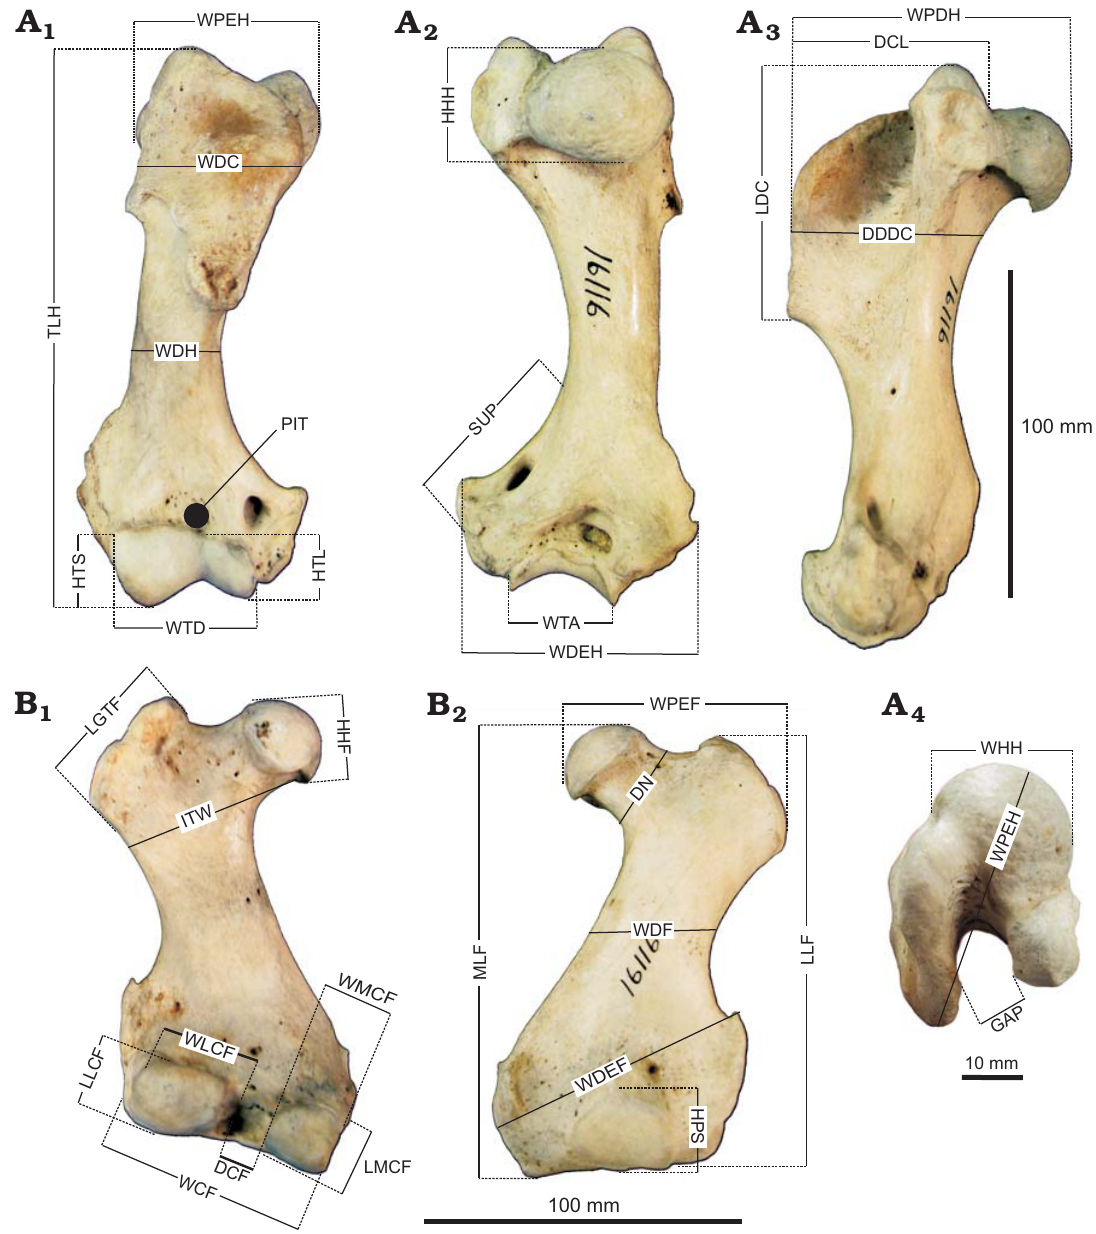
Fig. 1. Measurements of the earless seal humerus ( A ) and femur ( B ) used in morphometric analysis exemplified by Erignathus barbatus (USNM 16116). In anterior (A 1 , B 2 ), posterior (A 2 , B 1 ), medial (A 3 ), and proximal (A 4 ) views. Abbreviations: DCF, distance between condyles; DDDC, diameter of diaphysis at deltopectoral crest; DN, diameter of the neck of the femur; GAP, distance between head of humerus and deltopectoral crest; HHF, height of the head of the femur; HHH, height of head of humerus; HPS, height of the patellar surface; HTL, height of capitulum; HTS, height of trochlea; ITW, intertrochlear width of the femur; LDC, length of deltopectoral crest; LGTF, length of the greater trochanter; LLF, length of the lateral side of the femur; LLCF, length of the lateral condyle; LMCF, length of the medial condyle; MLF, length of the femur on the medial side; PIT, depth of coronoid fossa; SUP, length of supinator ridge; TLH, total length of humerus; WCF, width across condyles; WDC, width of deltopectoral crest; WDEF, maximum width of distal diaphysis; WDEH, maximum width of distal epiphysis; WDF, minimum width of diaphysis; WDH, minimum width of diaphysis; WHH, width of humeral head; WLCF, width of lateral condyle; WMCF, width of medial condyle; WPDH, width of proximal epiphysis, humeral head to lesser tubercle; WPEF, maximum width of proximal diaphysis; WTA, width of trochlea in anterior view; WTD, width of trochlea and capitulum in posterior